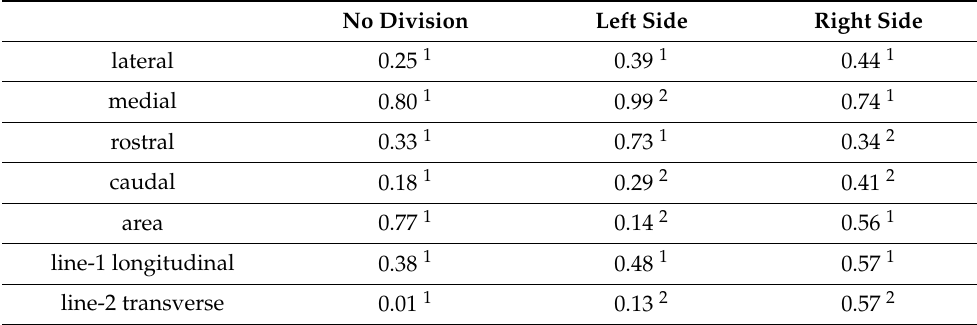
Table 3. The values of p parameter for comparison of measurements between the female and male group (t-student test for independent samples, Mann–Whitney U test). No